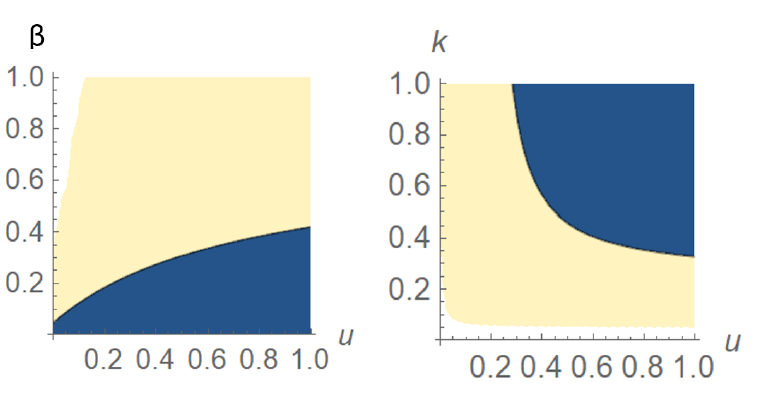
Figure 3. Investigation of R 0 ( β , u ) and R 0 ( k , u ) for u i ( t ) = u , β i = β , k i = k . R 0 < 1 only in blue